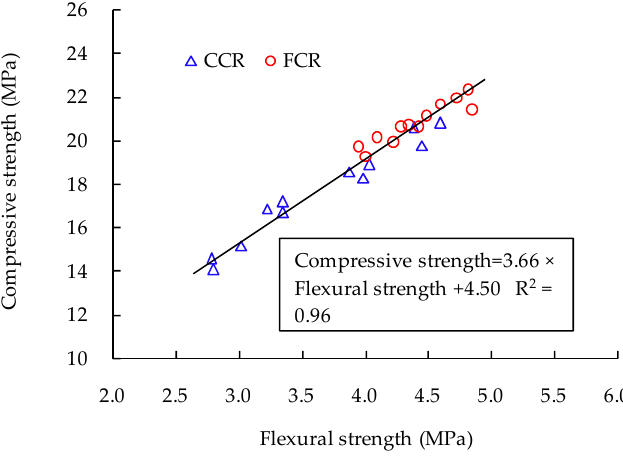
Figure 8. Flexural strength of RMPC versus rubber content.